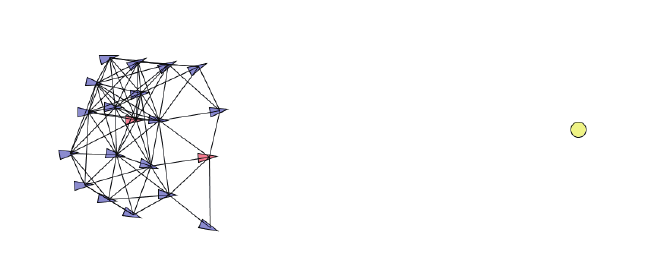
Figure 5: Last stage of the situation: The (cid:13)ock is stable. After the consensus of the direction of move- ment, the number of leaders becomes small. Red: leadership value (cid:11) (cid:21) 0 : 5(= leader ) , Blue: leadership value (cid:11) < 0 : 5 (follower), Link: interaction between